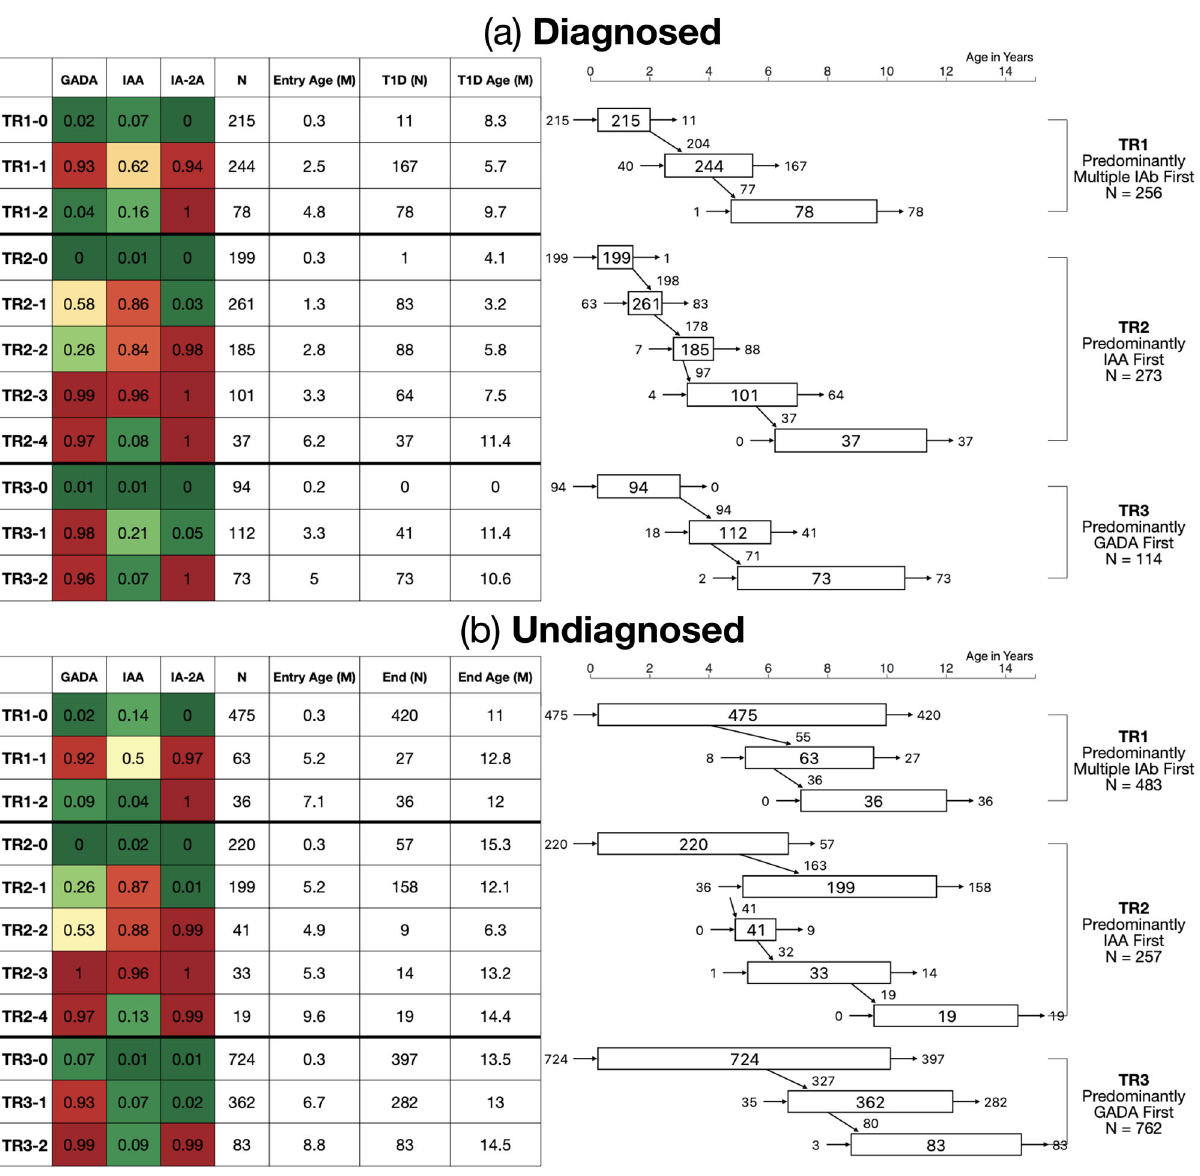
Fig. 2 State transition diagram for diagnosed and undiagnosed participants in the three trajectories. State transition diagram for D Diagnosed ( a ) and UD Undiagnosed ( b ). The table on left again shows probability of positivity for each islet autoantibody, total number of individuals in each state, median entry age (years) per state, number of individuals who are diagnosed (D) or lost in observation (UD) per each state and median age of type 1 diabetes diagnosis or last observation (years) for D and UD, respectively. Figure on right shows (i) how many participants enter each state (left-sided entry arrow); (ii) how many participants were diagnosed (D) or ended their observation (UD) at each state (right-sided exit arrow); (iii) how many participants progressed into subsequent states (diagonal transition arrow); (iv) how many participants are in each state (number in box). Each rectangle indicates median ages at the fi rst (left side) and last (right side) observations at each state in years of age on the x -axis. Source data are provided as a Source Data fi Survival analysis . Of the 2145 participants analyzed in both 67%), TR3 (mean = 88%; 95% CI: 85% to 91%). Of note, the groups, 1241 (58%) had at least one follow-up visit after the initial mean ages of initial entrance to IAb positive states were sig- IAb positive state (TR1-1, TR2-1, TR3-1). Survival analysis ni fi cantly different overall ( p < 0.0001); however, pairwise com- (Fig. 4) showed differences in progression to type 1 diabetes parisons showed that while mean entry age in TR3 was later than among trajectories after entry into initial IAb positive states. TR1 ( p < 0.0001) and TR2 ( p < 0.0001), there was no difference in Participants in TR1 progress faster to diabetes than those in TR2, age of entry between TR1 and TR2 ( p = 0.0728). who progress faster than those in TR3 (Fig. 4, p < 0.0001). Post- The survival curves strati fi ed on sex are provided in hoc analysis showed signi fi cant differences in all pairwise com- Supplementary Fig. 3. Females in TR2 showed faster progression parisons between trajectories ( p < 0.0001). The 5-year cumulative and lower rates of type 1 diabetes-free survival than males diabetes-free survival rates are signi fi cantly different (all pairwise ( Z 2 (1) = 5.7, p = 0.02). There was no signi fi cant difference between sexes in TR1 ( Z 2 (1) = 0.3, p = 0.6) or TR3 differences, p < 0.0001): TR1 (mean = 40%; 95% Con fi dence ( Z 2 (1) = 2.3, p = 0.1). Interval [CI]: 35 % to 47%), TR2 (mean = 62%; 95% CI: 57% to